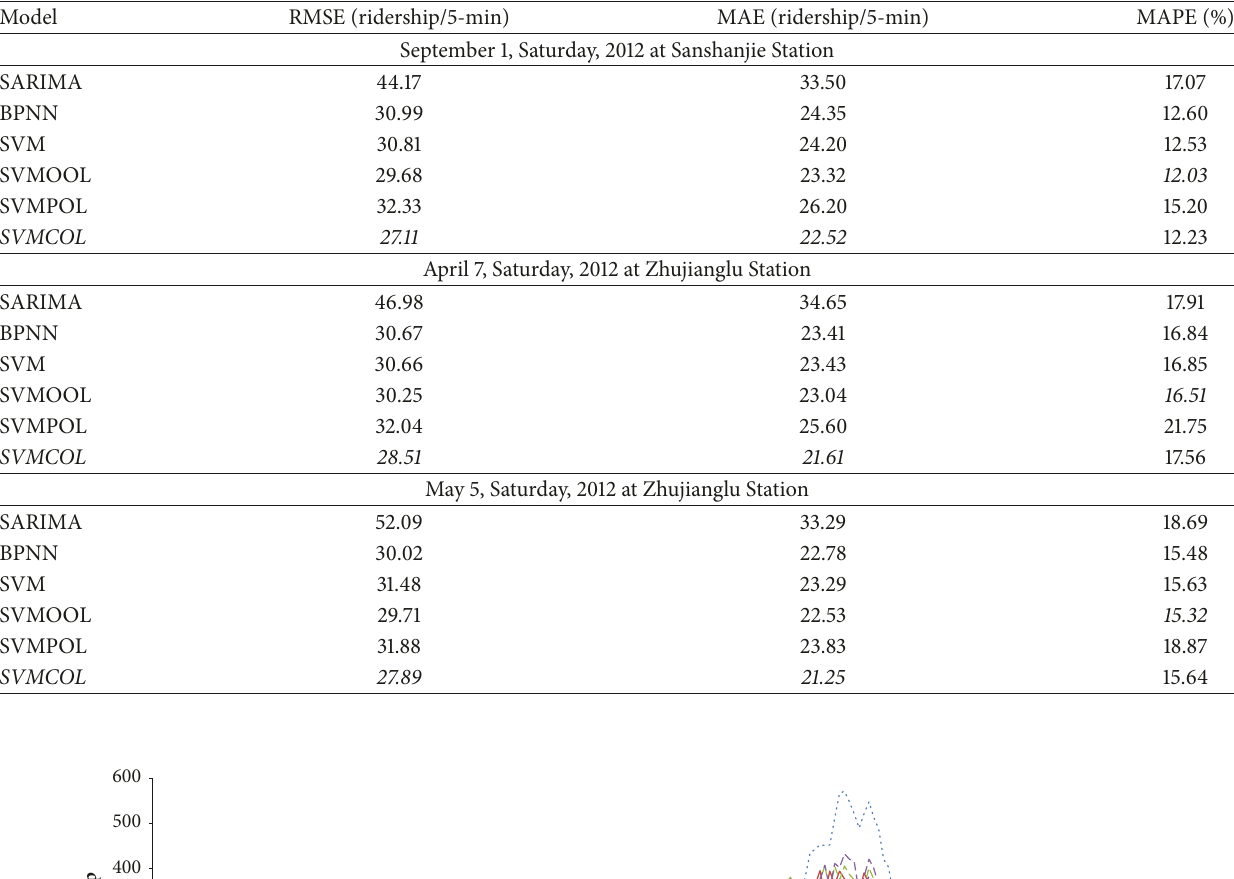
Table 3: weekend performance comparison for one-step prediction.